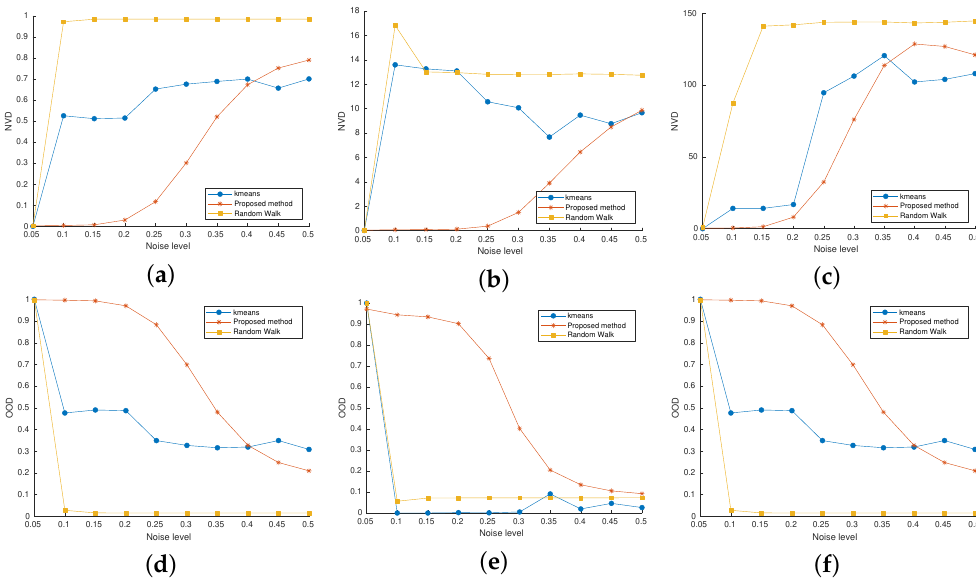
Figure 9. Performance comparison between the RaWaCs algorithm (orange), the k -means algorithm (blue) and the random walk method (yellow) with respect to the noise level. ( a – c ) NVD for labels referring to the background, the red square and the blue lines of Figure 4a. ( d – f ) OOD for labels referring to the background, the red square and the blue lines of Figure 4a. The last label presents high challenges in its segmentation due to its thinness and